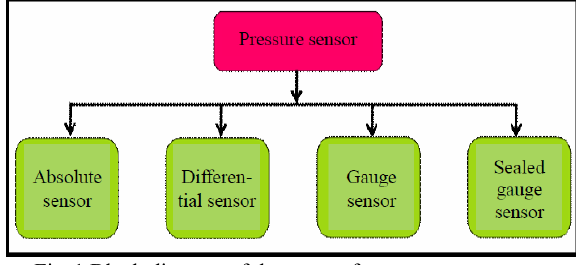
Fig. 1 Block diagram of the types of pressure sensors.